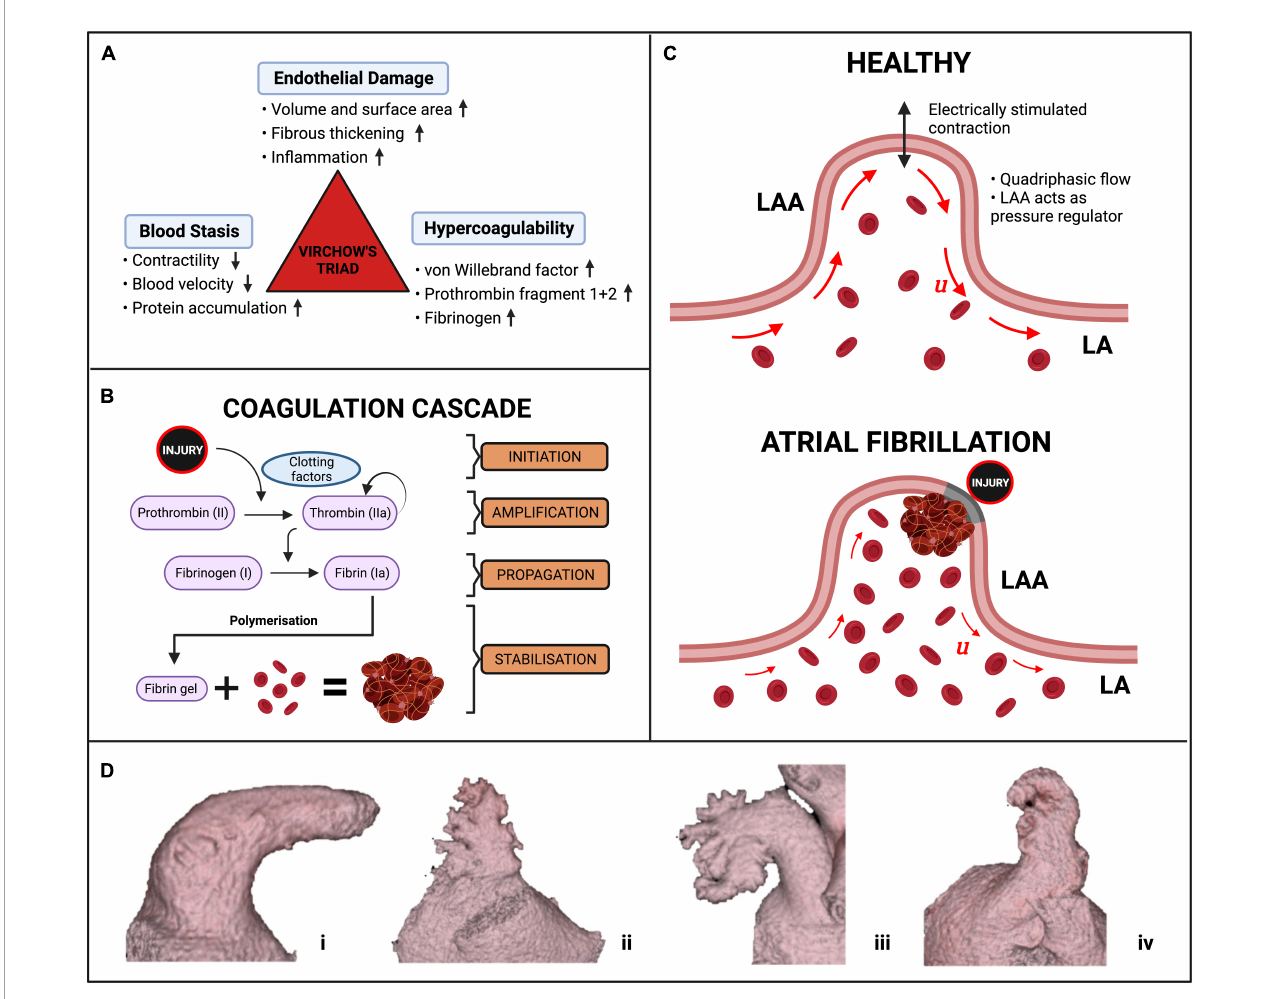
FIGURE1 AF and thrombus formation. (A) The components of Virchow’s triad for thrombus formation. (B) The simplified coagulation cascade. (C) Schematic of thrombus formation in a diagram of an LAA. The red arrows represent the magnitude and direction of blood flow velocity u inside the LAA in normal conditions (top) and during AF with accumulation of erythrocytes (bottom). (D) The four morphologies of the LAA, (i) chicken wing, (ii) cactus, (iii) broccoli, (iv) windsock